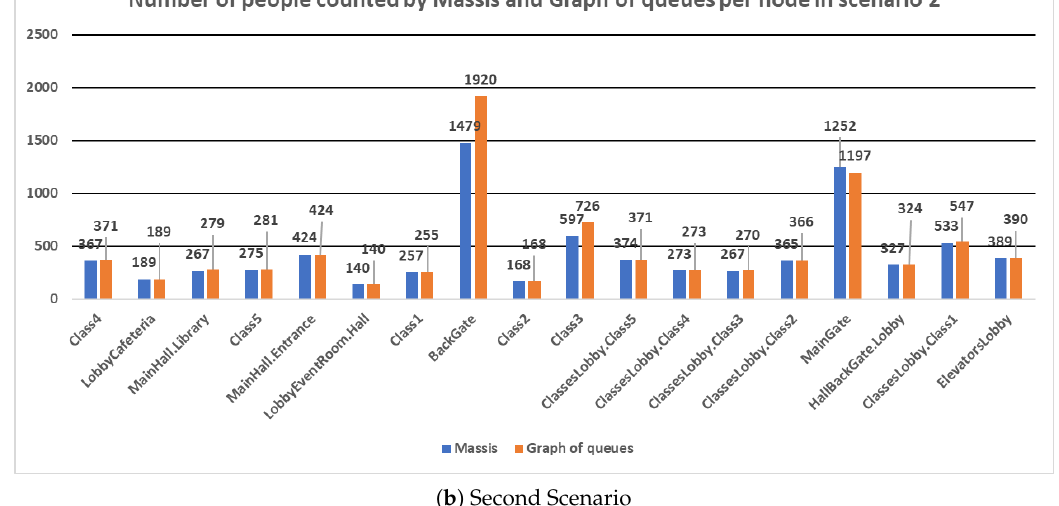
Figure 5. Experiments results comparing MASSIS and graph of queues per node in the first and second